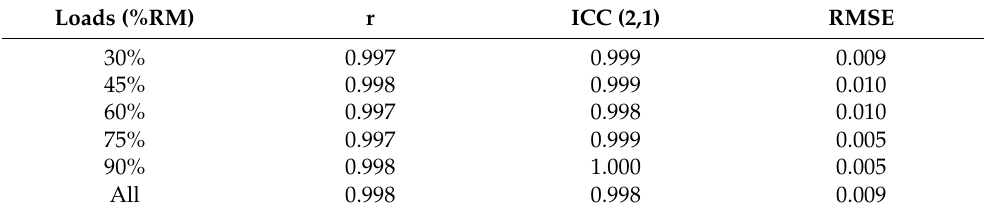
Table 1. Pearson’s correlation coefficient (r), intraclass correlation coefficient (ICC), and root mean square error (RMSE) of concentric mean velocity measured by the full-waveform resistance training monitoring system (FRTMS) and the OptiTrack system during different loads.